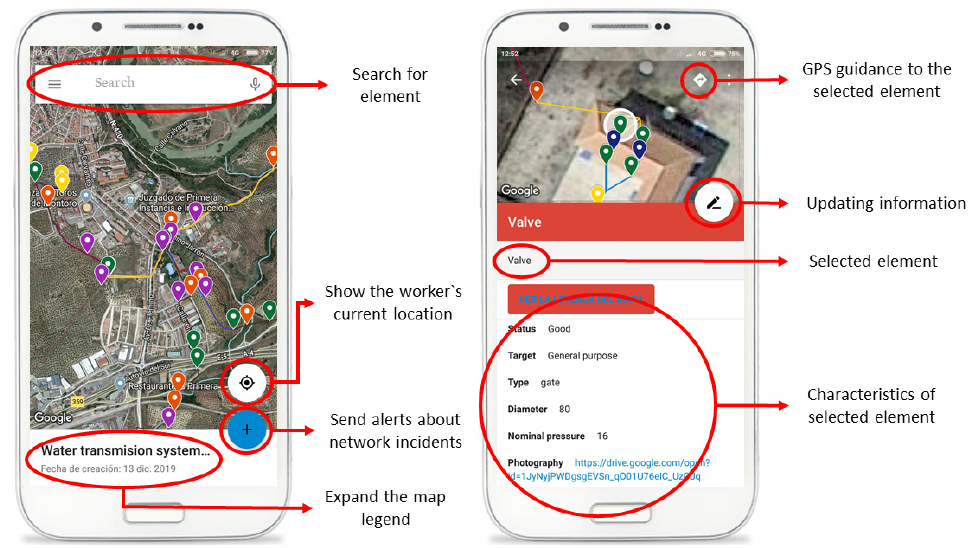
Figure 7. ITWSM-app graphical interface.